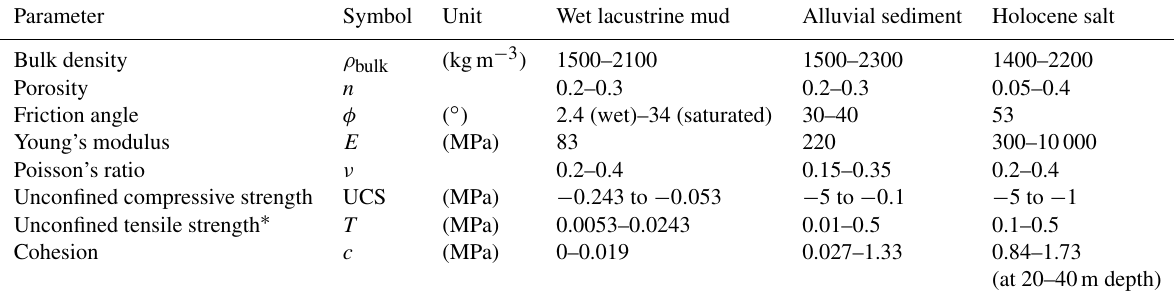
Unconfined tensile strength